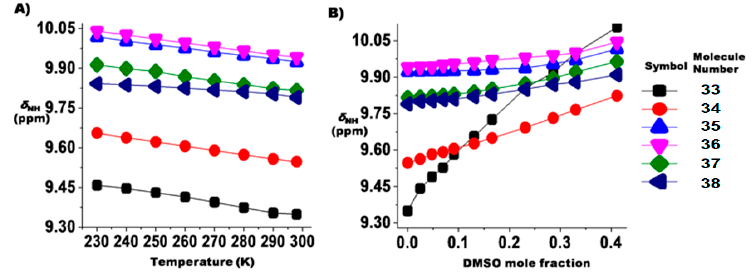
Figure 34. The variation of the chemical shift of NH proton ( A ) with temperature; ( B ) with the incremental addition of DMSO- d 6 to the solution containing 200 µL of CDCl 3 . The 10 mM concentration at 298 K for the molecules, 33 – 38 has been initially taken for both the studies.